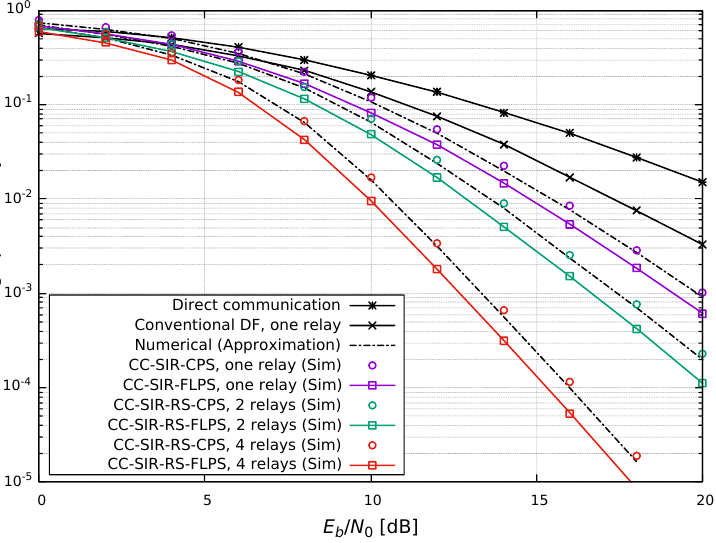
Figure 5. Numerical and simulated outage probability results versus SNR per information bit E b / N 0 at the destination of the CC-SIR-RS-CPS scheme ( ρ r = 0.5 for all relays) and simulated outage results of the CC-HIR-RS-FLPS scheme for different number of relays, direct communication, and one relay communication applying conventional DF strategy for R = 0.5